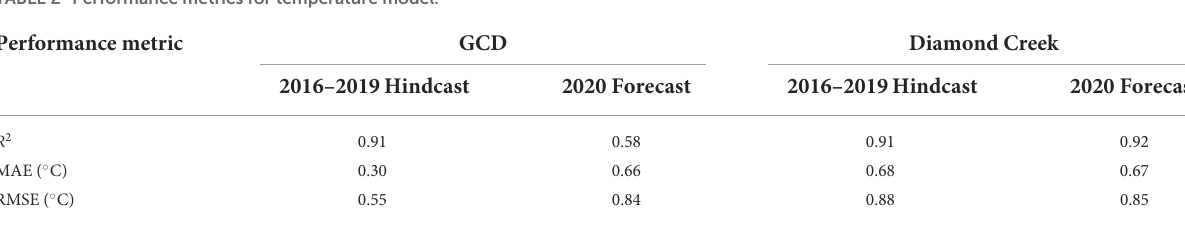
TABLE 2 Performance metrics for temperature